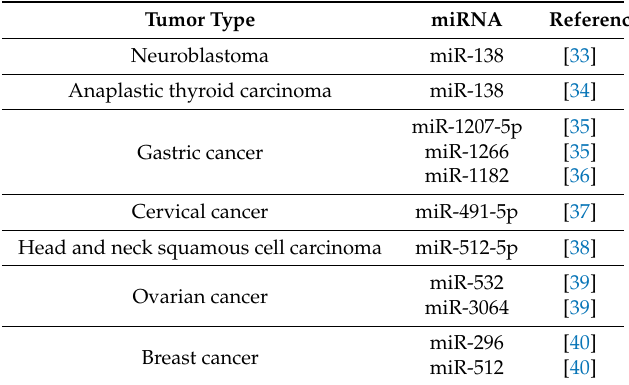
Table 1. hTERT regulation by